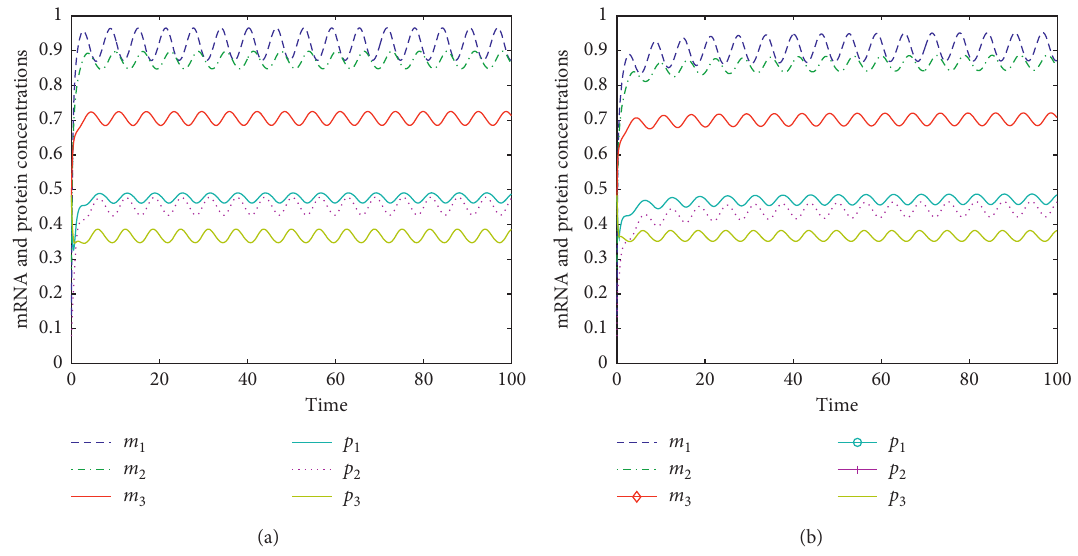
Figure 3: Numerical simulations of DFGRN (62) with (a) q � 0 . 95 and (b) q � 0 . 6.